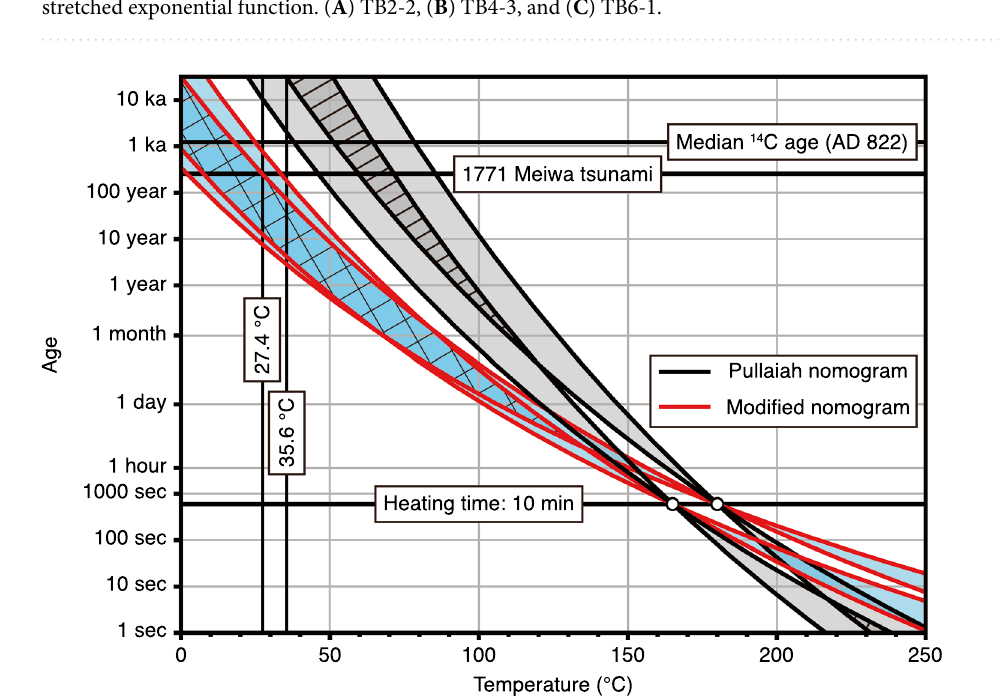
Figure 6. Pullaiah and modified nomograms for the tsunami boulder (TB2). The white circles represent the unblocking temperatures of the samples. The black curves were calculated with the Pullaiah nomogram and red curves represent the modified nomogram. Gray areas indicate the unblocking ranges of the Pullaiah nomogram and the area with hatched lines represents areas overlapping with the gray areas. The blue areas are the unblocking ranges of the modified nomogram and the area with cross-hatched lines represents areas overlapping with the blue